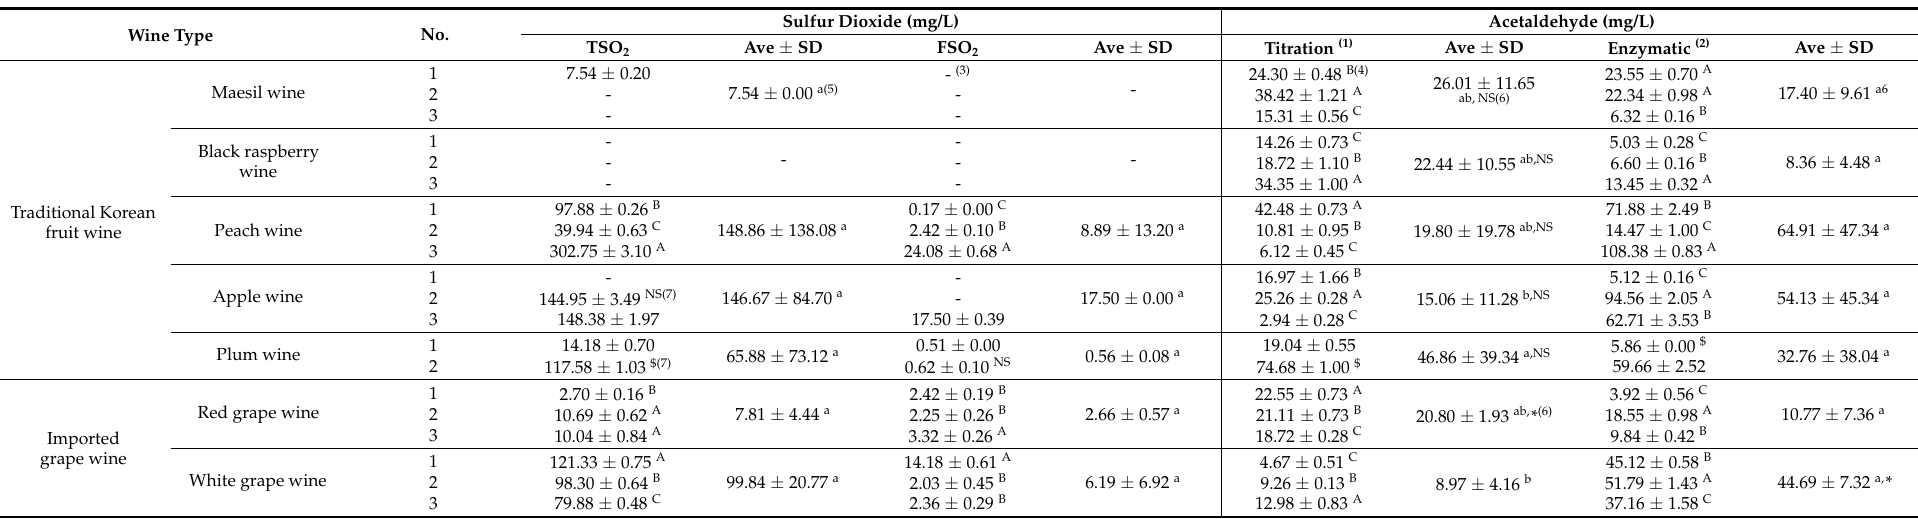
Table 3. The contents of sulfur dioxide and acetaldehyde in fruit